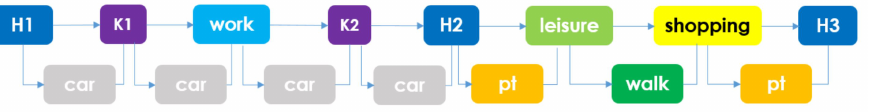
Figure 23. Activity plan